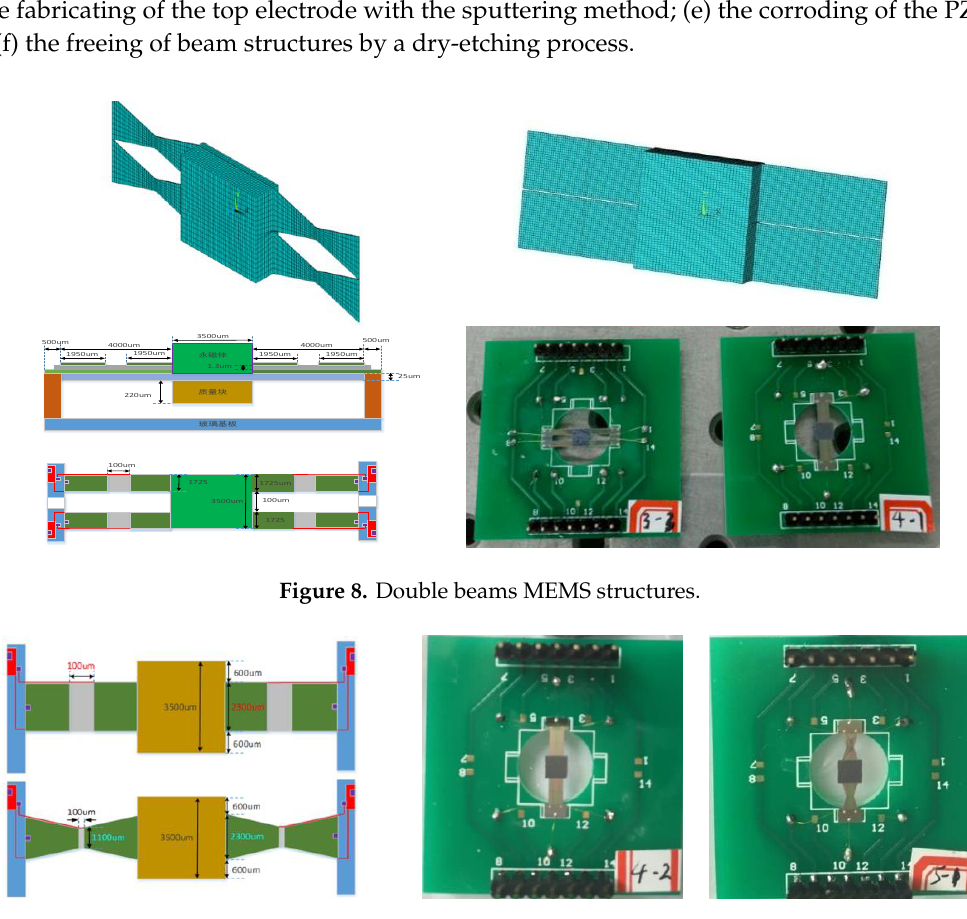
Figure 9. Single beam microelectromechanical system (MEMS) structures.